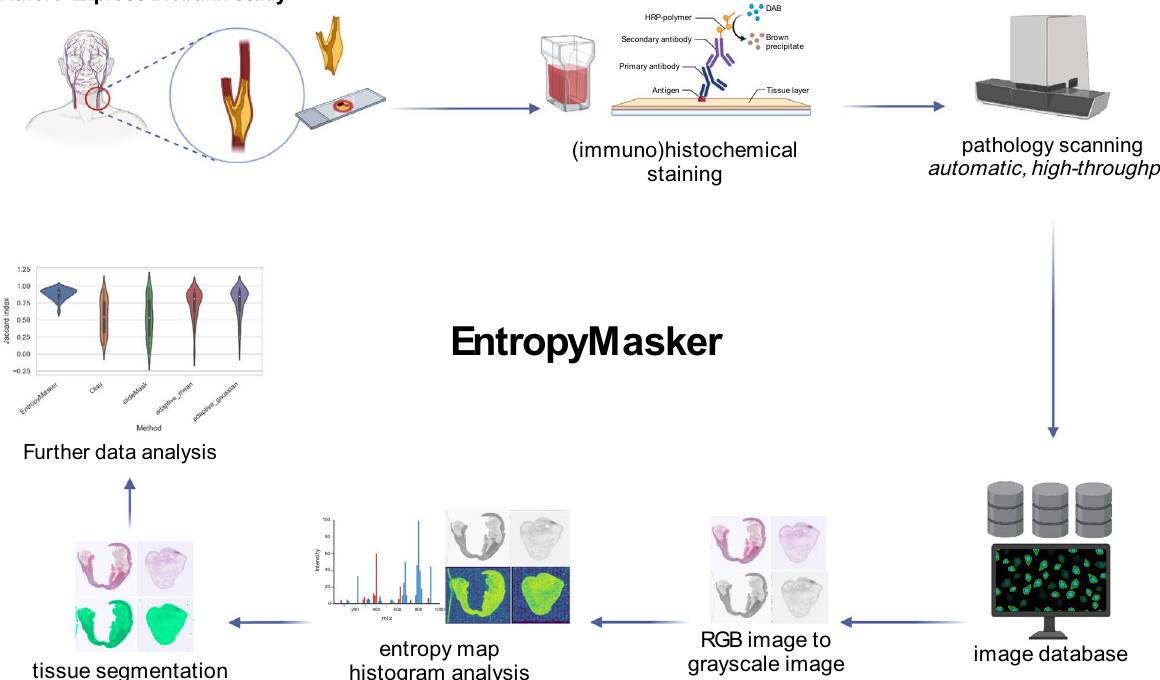
WSIs from Athero-Express (Supplemental Table 1 for a minimalistic baseline table and Supplemental Table 2 for details on usage) at 40X magnification on layer 6 (pixel spacing at layer 6 is around 8.36 µm) consisting of 8 different stains: HE, picrosirius red, Fibrin, EVG, a-SMA, CD34, CD68, and GLYCC. We did not apply our method to layer 1 due to memory constraints. The average Jaccard index, also referred to as the Intersection over Union (IoU) metric, of the adaptive thresholding method where its threshold value is the weighted sum of neighborhood values where weights are a gaussian window was 0.7702 and the average sensitivity was 0.8597 (Table 1, Supplemental Table 3 includes results for all stains and methods). This masking method produced the highest pixel accuracy among all the traditional methods which was 0.9485. Otsu’s method had a much lower false positive rate than any of the approaches examined at the cost of much lower average Dice scores and sensitivity levels. The quality of the outcome of the